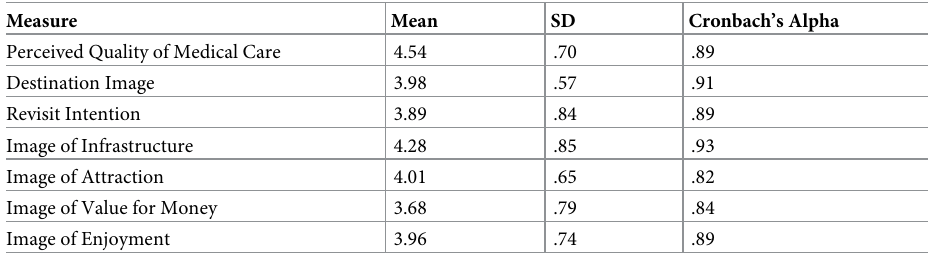
Table 2. Descriptive statistics and reliability